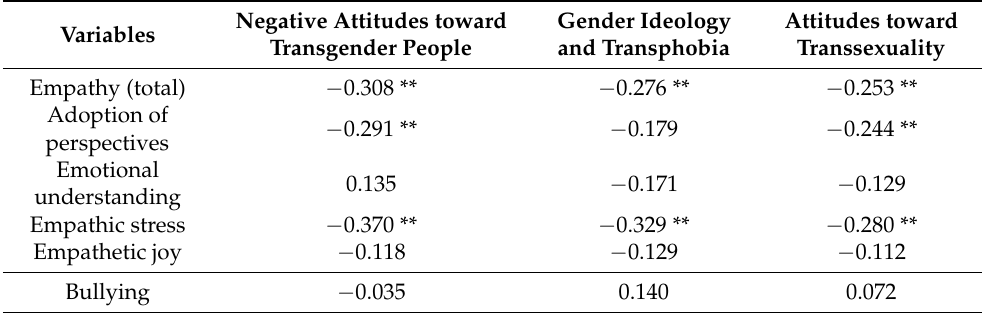
Table 2. Correlations between the negative attitudes toward transgender people, gender ideology and transphobia; attitudes toward transsexuality, cognitive and affective empathy; and bullying in university